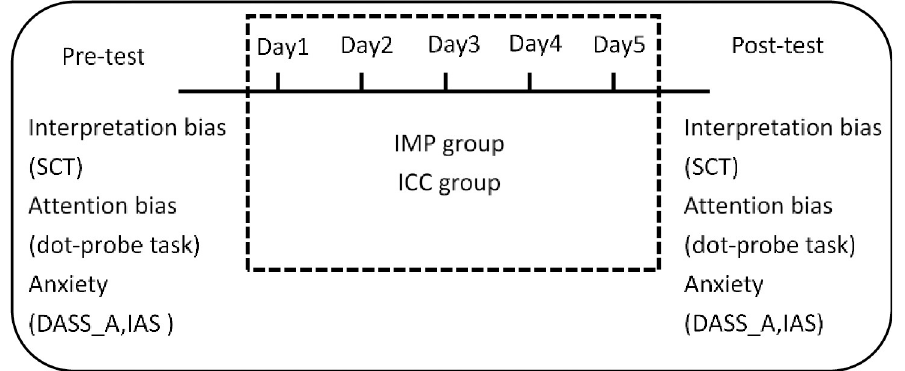
Fig 3. Repeated measure study procedure. SCT = sentence completion task; IAS = interpersonal anxiety scale; DASS_A = anxiety subscale in depression anxiety stress scale; IMP = interpretation modification program; ICC = interpretation control